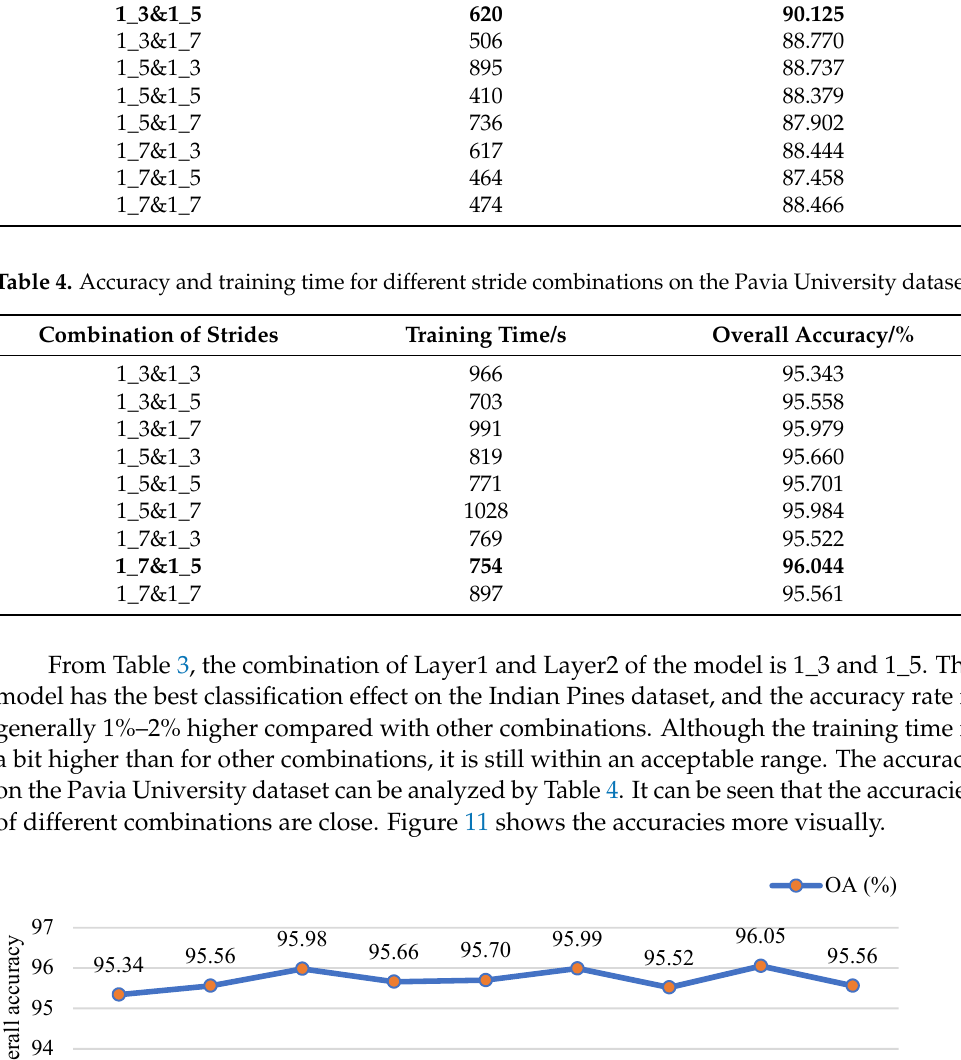
Table 3. Accuracy and training time for different stride combinations on the Indian Pines dataset.